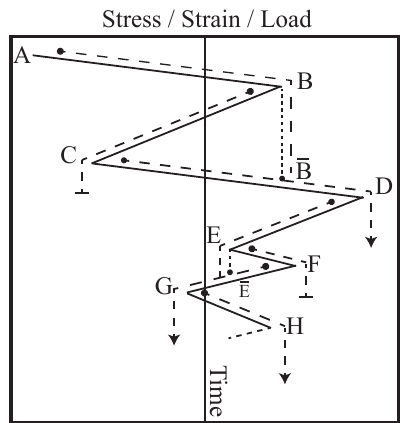
Figure 19: Example of rainflow algorithm